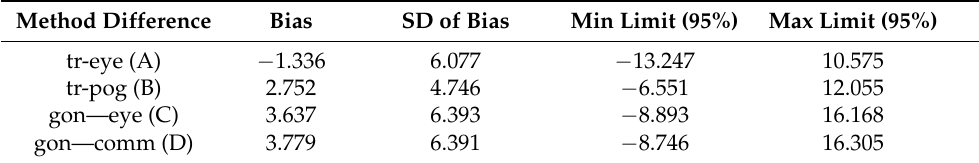
Figure 5. Bland − Altman plots for each demarcation line measurements ( a )—Limits of agreement for A line ( b )—Limits of agreement for B line ( c )—Limits of agreement for C line ( d )—Limits of agreement for D line. Table 4. Limits of agreement.